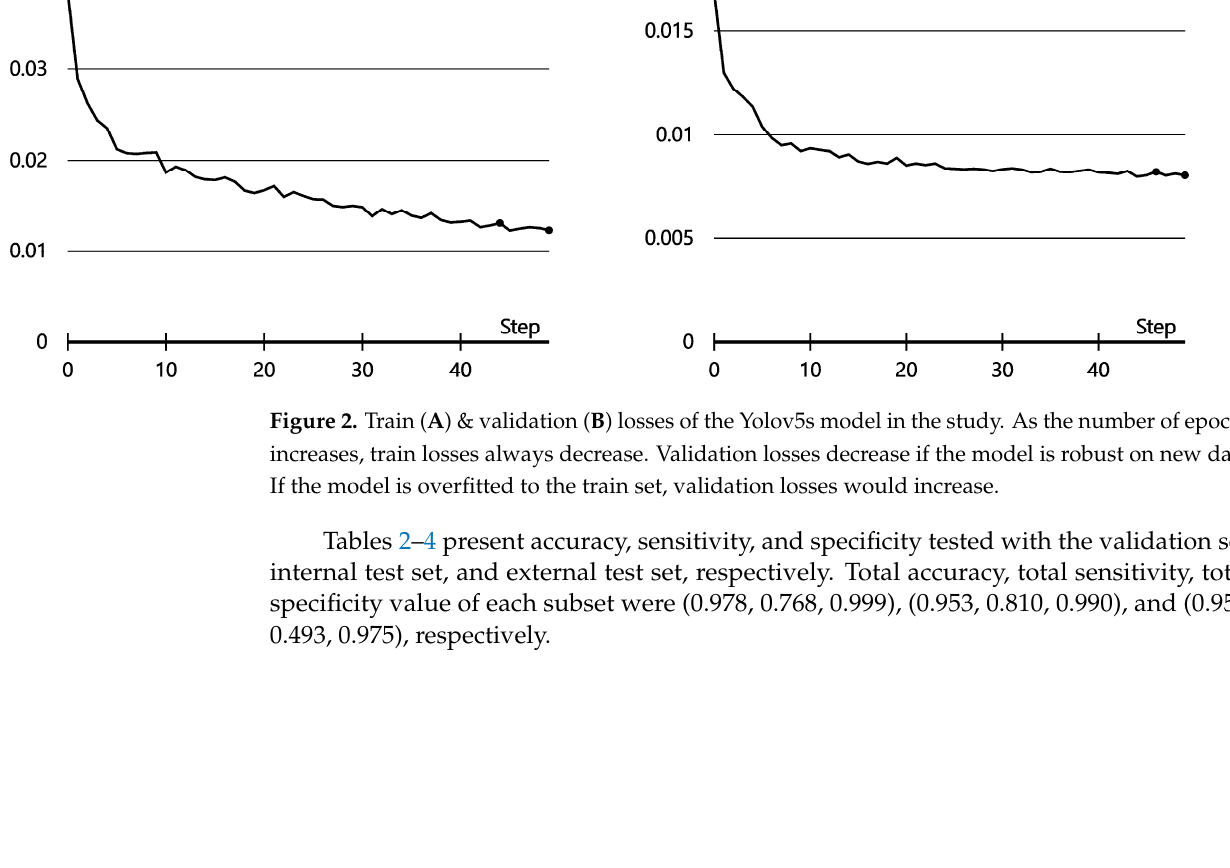
Table 2. Evaluation metrics on the validation set.